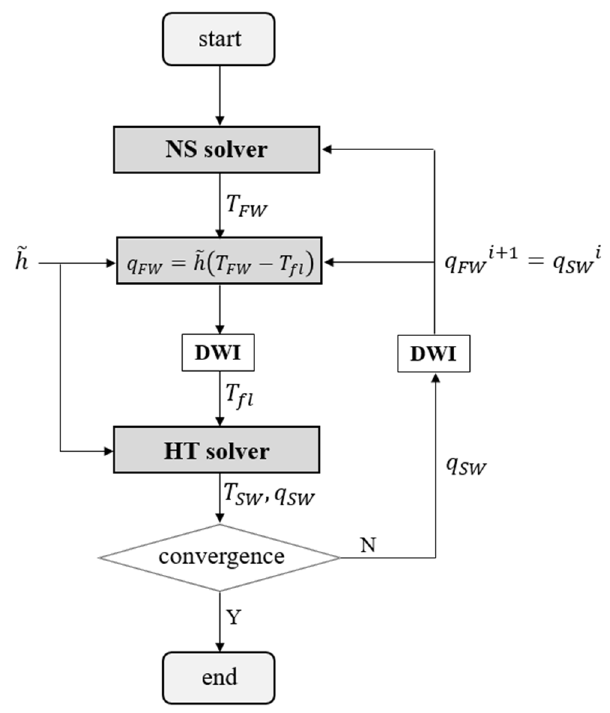
Figure 4. hFFB coupling method for the CHT analysis.